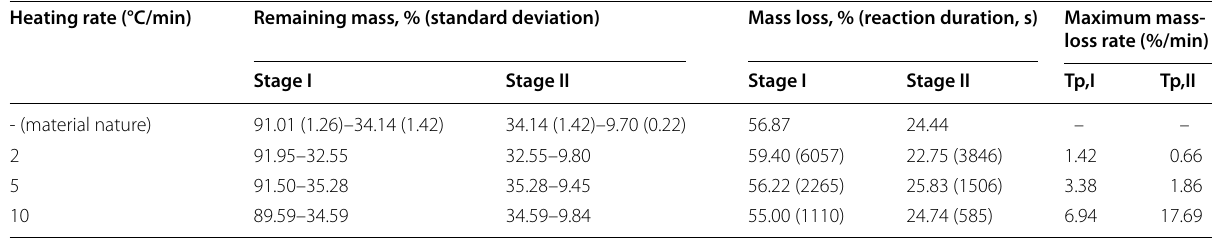
Table 3 Mass changes including reaction durations of the combustion reaction under different heating rates Heating rate (°C/min) Remaining mass, % (standard